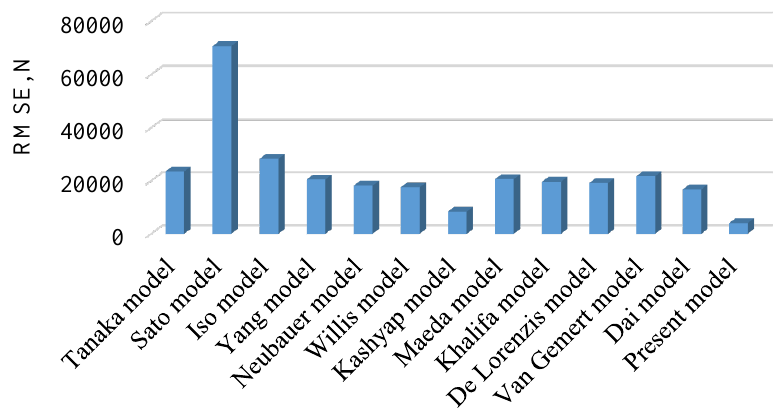
Figure 3. Observed and predicted debonding forces by GEP for ( a ) training and ( b ) testing data